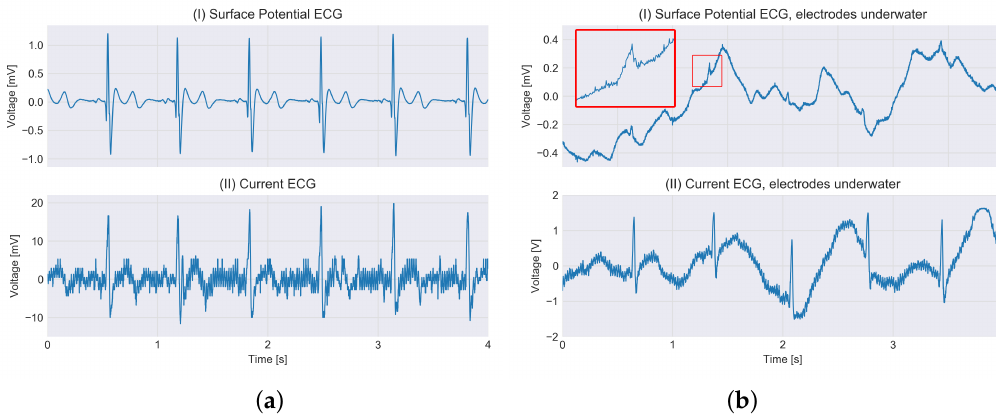
Figure 5. Left side ( a ): Comparison between a commercial surface potential-based ECG (I) and the current-based ECG in the wide bandwidth configuration (II), both showing the same six heartbeats of one healthy person not immersed in water. The potential ECG was filtered in its device while the current-based ECG was not post-filtered, e.g., using a notch filter, at all to allow inspection of the signal behavior around the QRS complex and the influence of the power-line interferences. Measurement electrodes were placed in a lead II configuration. Right side ( b ): Comparison between a commercial surface potential-based ECG (I) and the current-based ECG in the wide bandwidth configuration (II), both showing a 4s window of the measured ECG with the torso and the attached electrodes fully submerged in water. Both measurements were made with metal-plate electrodes from one healthy person. The QRS complexes of the potential ECG are hardy measurable any more and are severely distorted due to the loss in signal strength. In contrast, the current ECG also shows some baseline wandering, however it is overall much more stable also in the amplitudes of the QRS complexes, which even show an increased signal-to-noise ratio compared to dry